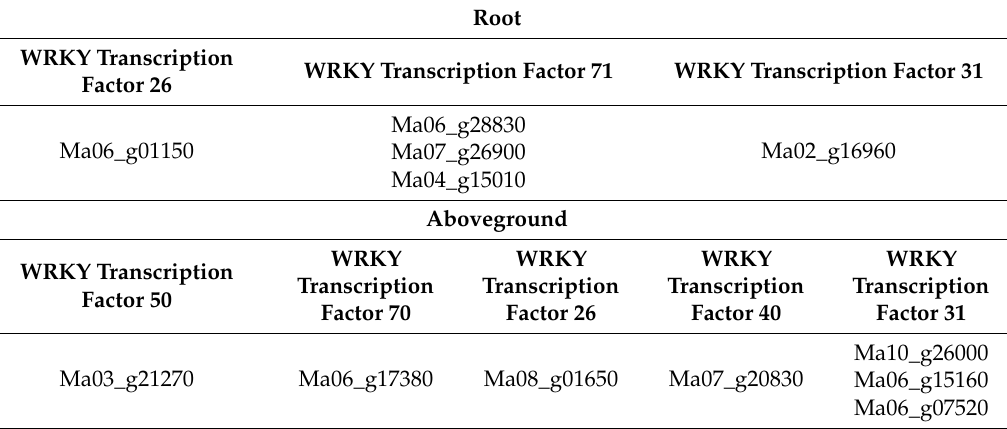
Table 5. WRKY transcription factor